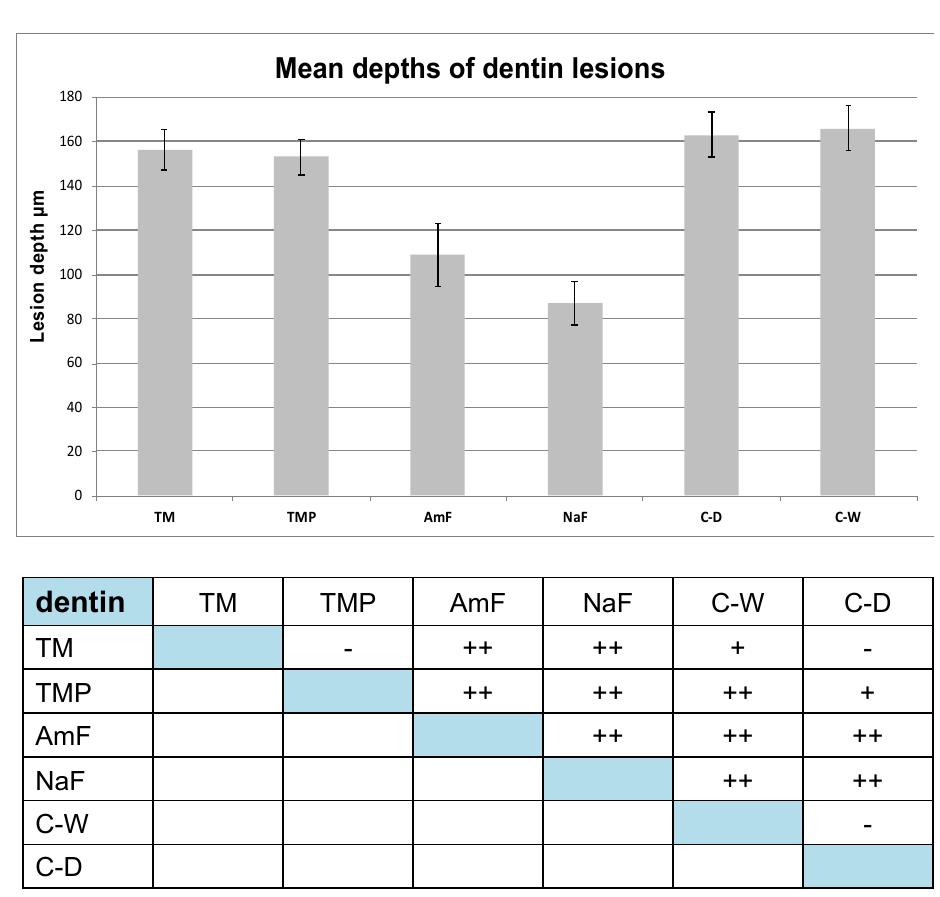
Figure 4. Mean lesion depths and standard deviations of dentin lesions. Below the statistical evaluation of lesion depths regarding significance between the different test groups for dentin groups: − not significant ( p ≥ 0.05); + significant ( p ≤ 0.01); ++ highly significant ( p ≤ 0.001). Data were analyzed by ANOVA i.a.